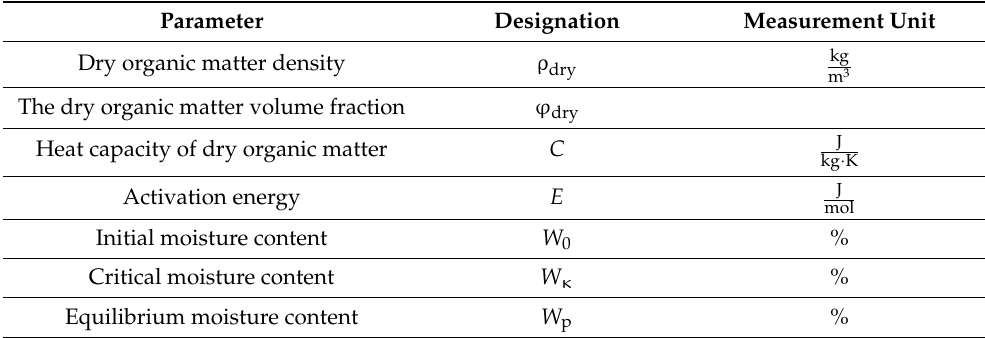
Table 1. Set of input